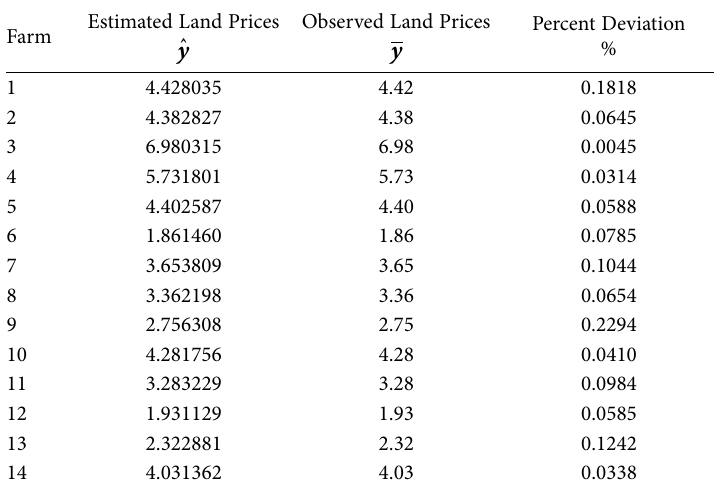
Table 9. Deviations of y ˆ from y